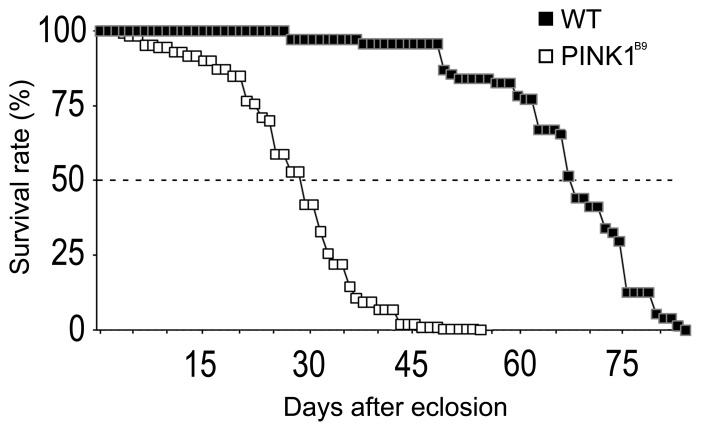
Lifespan in wild type and PINKB9 mutant adults.The graph shows the survival rate observed in wild type and PINK1B9 mutants. PINK1B9 had a reduced lifespan compared to WT.PINK1B9 flies started to die dramatically at the 15th days after eclosion with 50% of flies being dead after 30 days (P<0.0001).